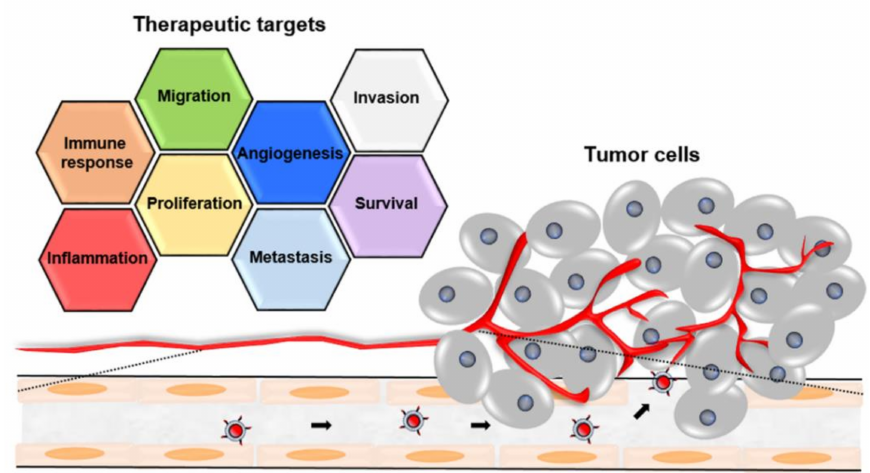
Figure 2. Multiple potential therapeutic targets involved in tumor